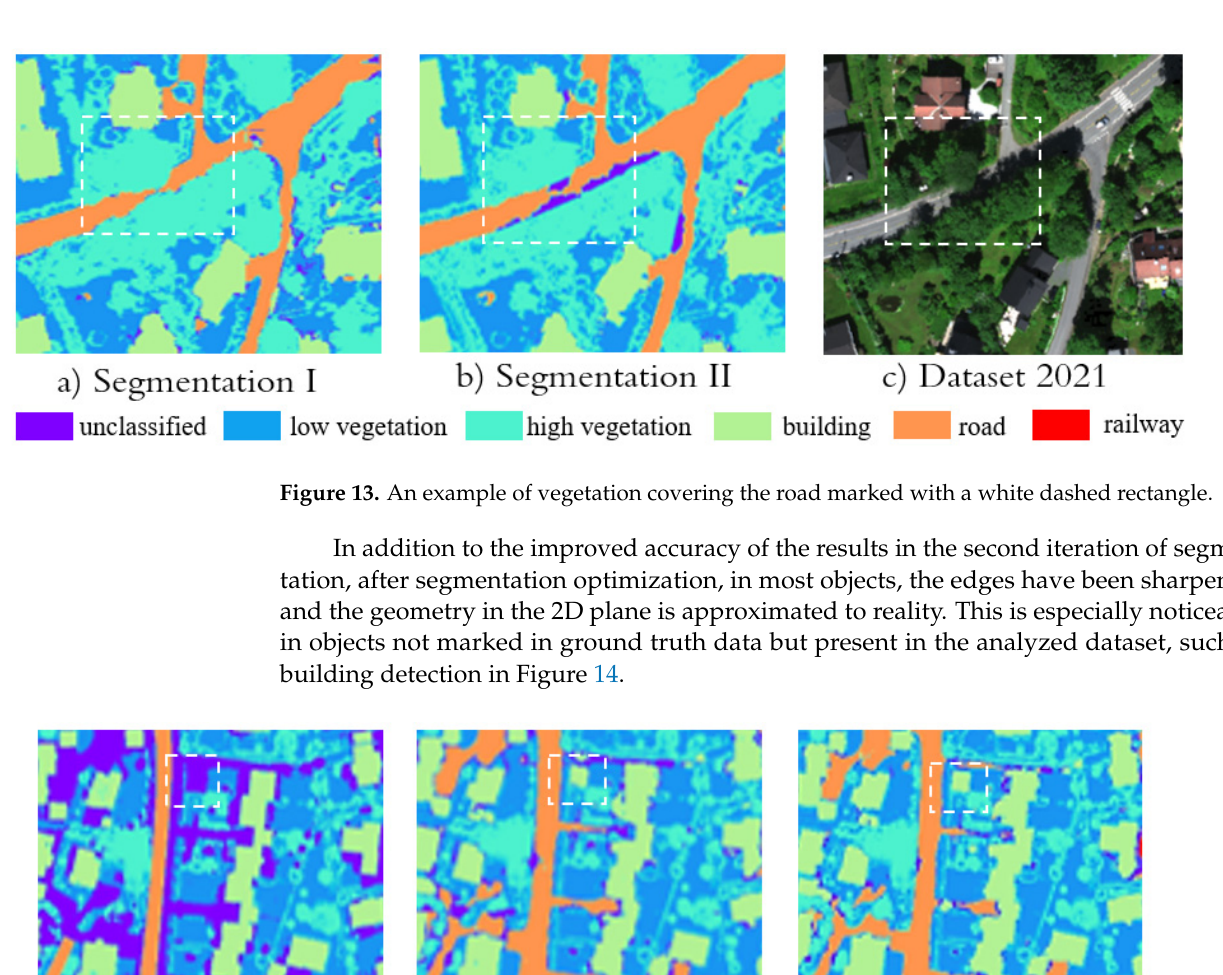
Figure 13. An example of vegetation covering the road marked with a white dashed rectangle.